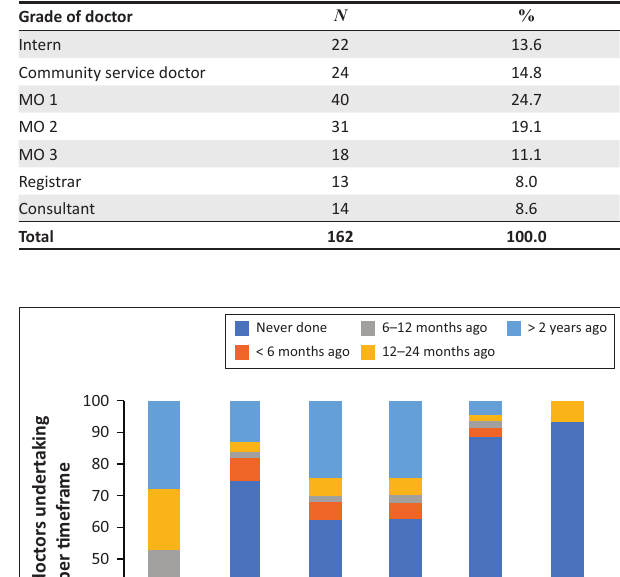
TABLE 1: Grade of doctor.